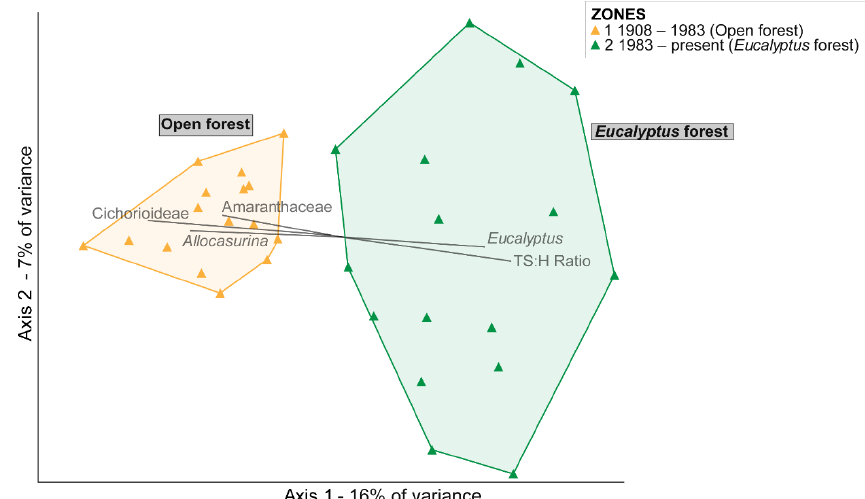
Figure 4. DCA ordination biplot showing the direction of correlation (cut-off r 2 value = 0.5) of pollen taxa with the ordination axes. Samples are grouped according to CONISS zones and naming follows the characteristic taxa that define each zone. For interpretation of the references to colour in this figure legend, the reader is referred to the web version of this